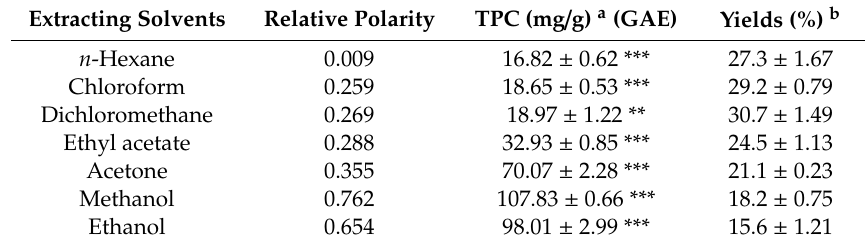
Table 1. Total phenol contents and extraction yields of Myristica fragrans with each extraction solvent.